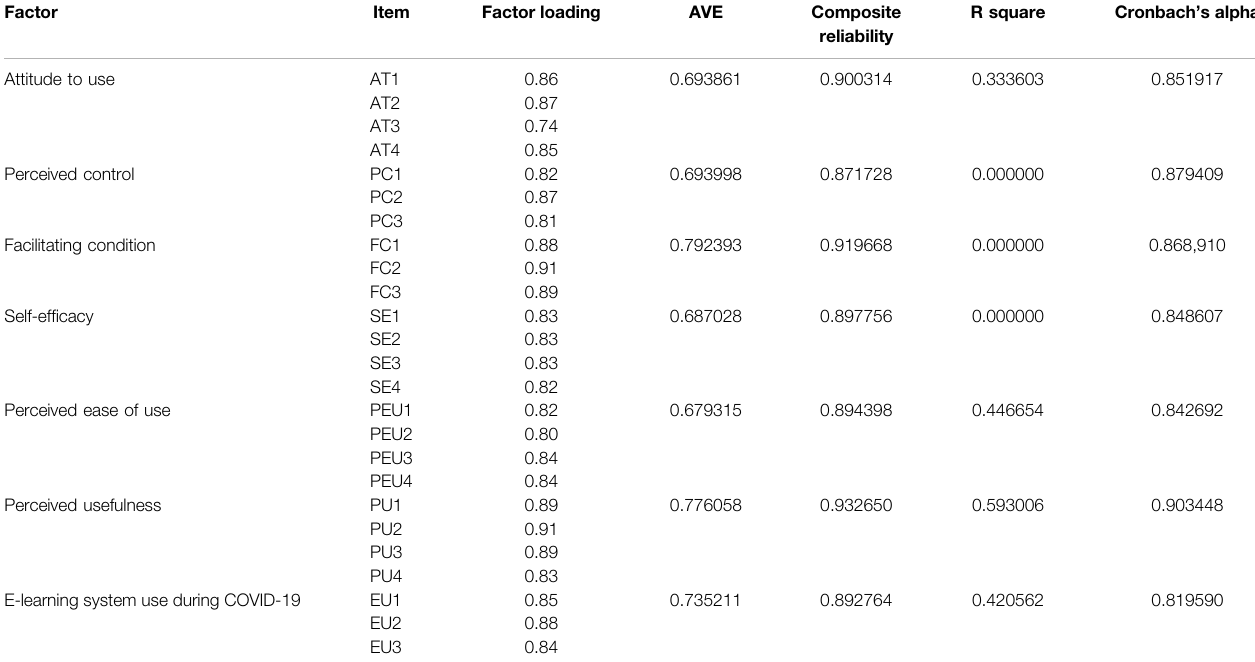
TABLE 2 | Crematory factor analysis of the measurement